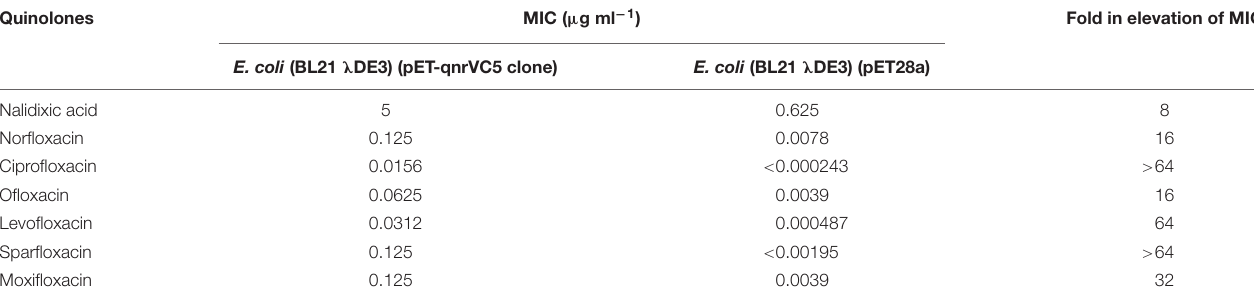
TABLE 3 | MIC of quinolones for pET-qnrVC5